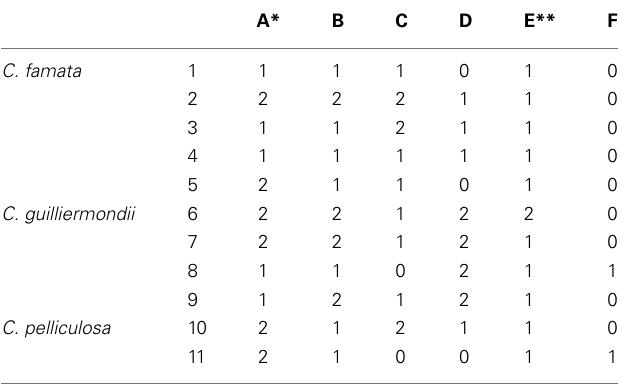
Table 3 | Data used to run multivariate